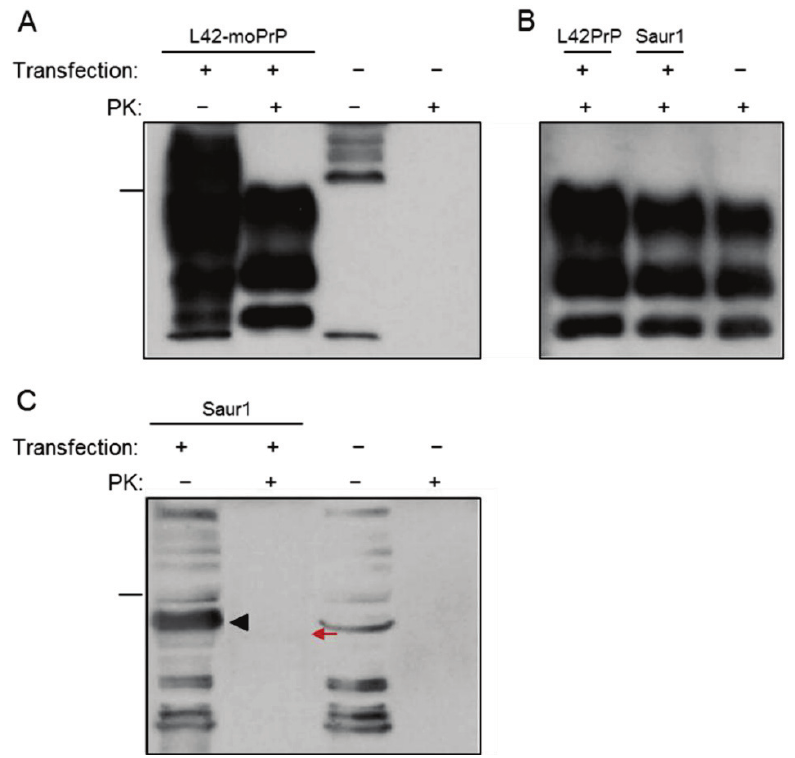
Figure 6. Evaluation of mature SaurPrP1 conversion potential in the 22L-ScN2a cell line. Western blot analysis of 22L-ScN2a cells transfected with mouse or fish recombinant proteins (transfection +) and non- transfected (transfection −) control cells. ( A ) Positive conversion control, cells transfected with L42-moPrP (L42, 1:10); ( B ) Endogenous PrP Sc , cells transfected with fish and mouse PrPs (6H4, 1:5000); ( C ) SaurPrP-1 conversion potential (SaurPrP1, 1:1000). PK concentration, 5 μg/mL. Arrowhead indicates recombinant SaurPrP-1. Red arrow indicates faint PK-resistant band. Relative molecular mass markers, 32.5 kDa ( A , B ), 62 kDa ( C